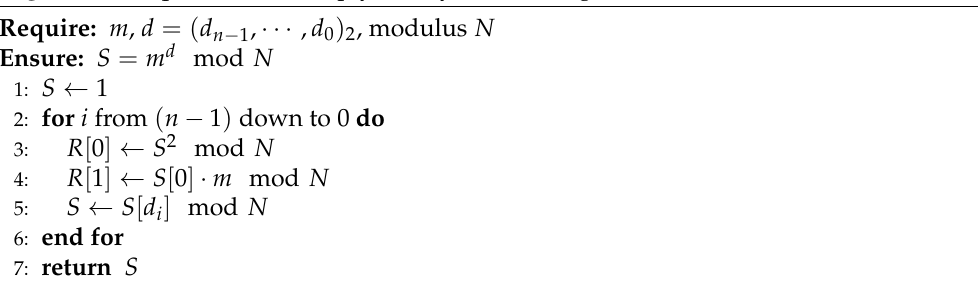
Algorithm 2 Square-and-Multiply Always, Left to Right